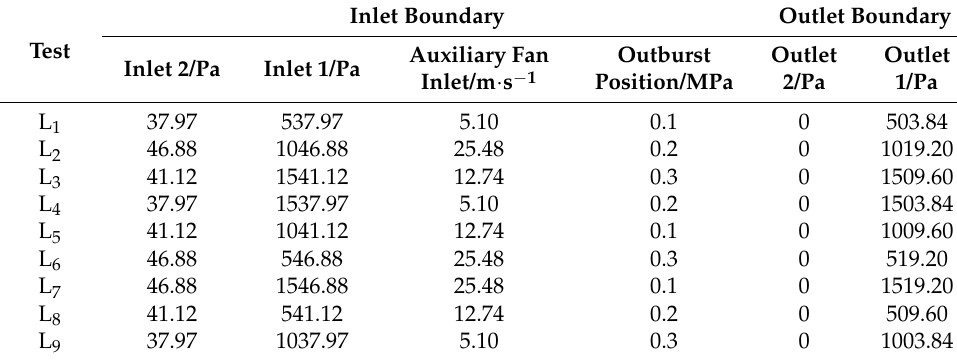
Table 3. Boundary conditions of each